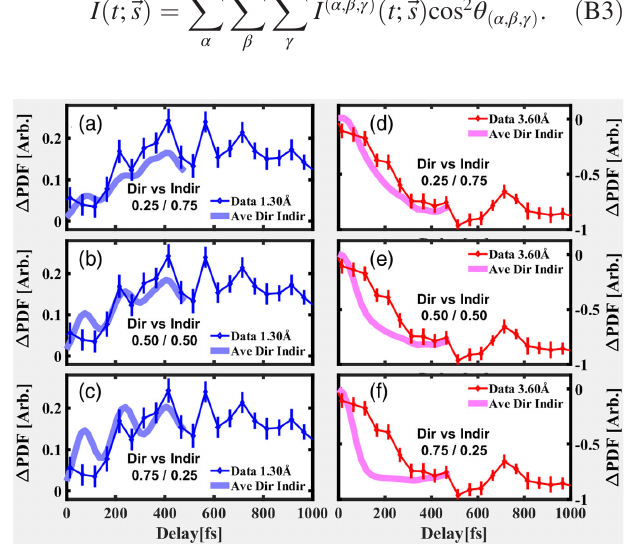
FIG. 18. Analysis of direct and indirect trajectory weighting. Panels (a) and (d) show the measured and calculated Δ PDF at 1.30 Å and 3.60 Å, respectively, for a 0 . 25 = 0 . 75 weighting of direct vs indirect trajectories in the average. Panels (b) and (e) show the measured and calculated Δ PDF at 1.30 Å and 3.60 Å, respectively, for a 0 . 50 = 0 . 50 weighting of direct vs indirect trajectories in the average. Panels (c) and (f) show the measured and calculated Δ PDF at 1.30 Å and 3.60 Å, respec- tively, for a 0 . 75 = 0 . 25 weighting of direct vs indirect trajectories in the